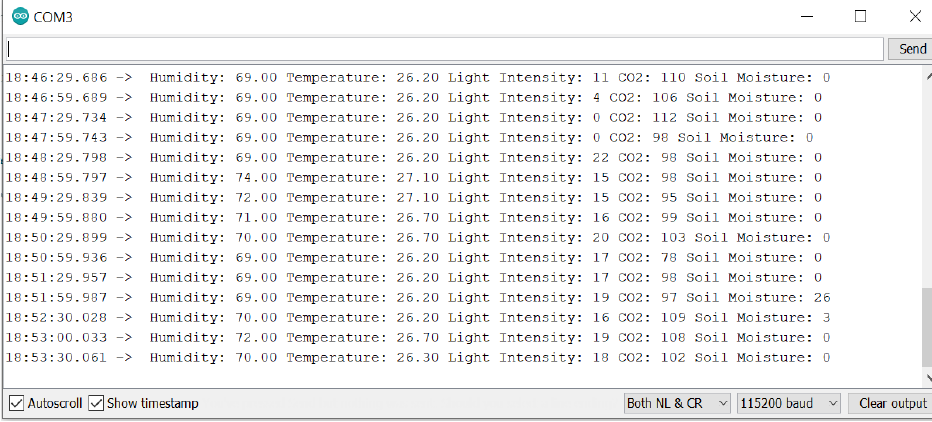
Figure 8. Sensor output on serial monitor with timestamp values.